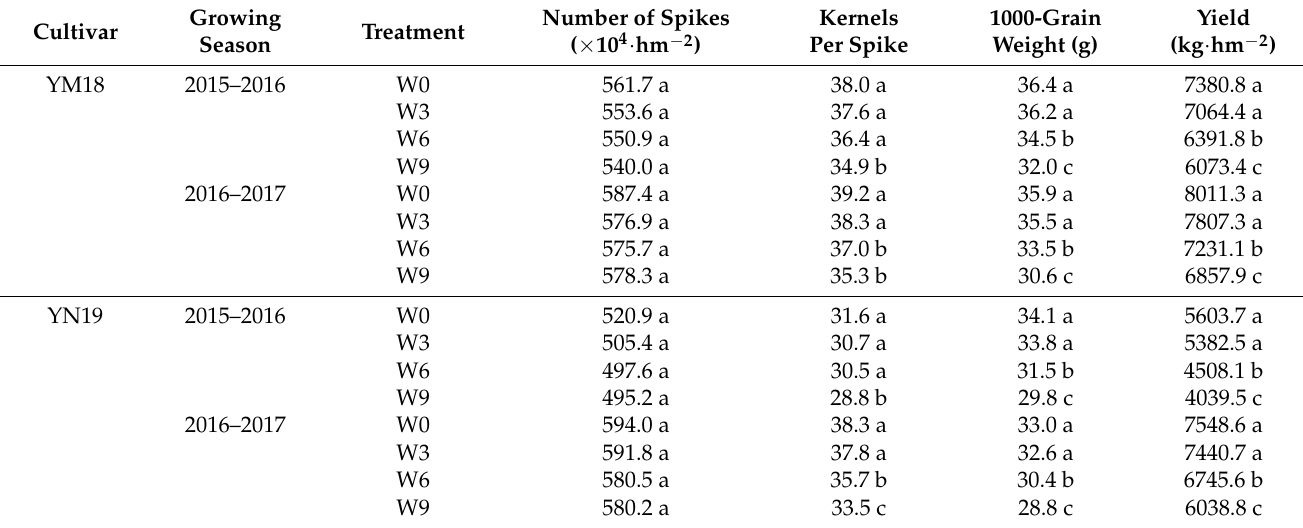
Table 5. Wheat yield and components under different